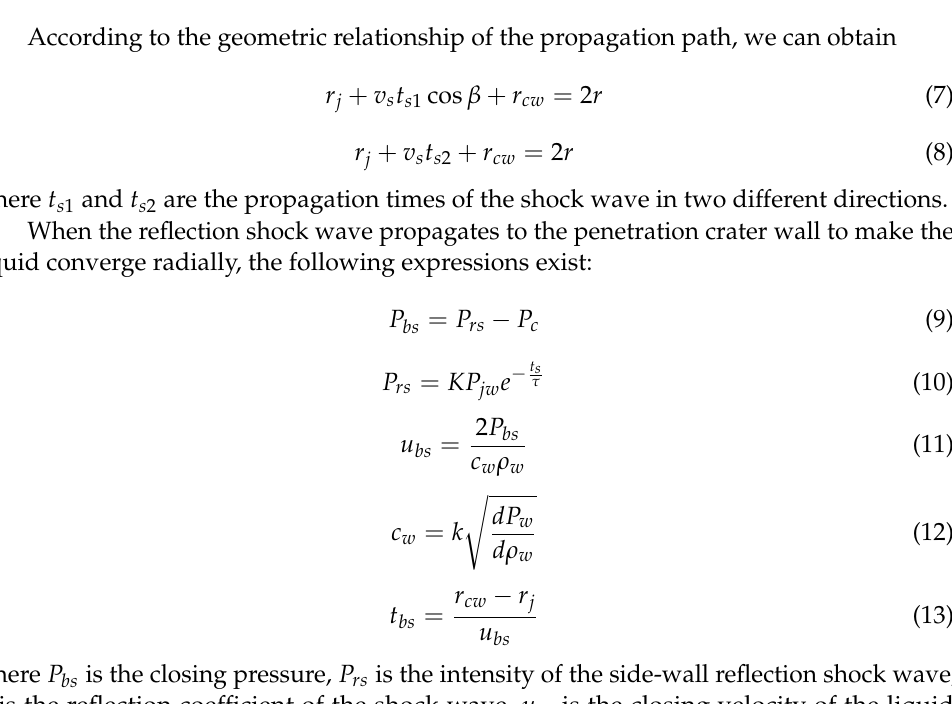
Figure 3. Propagation path of the shock wave.